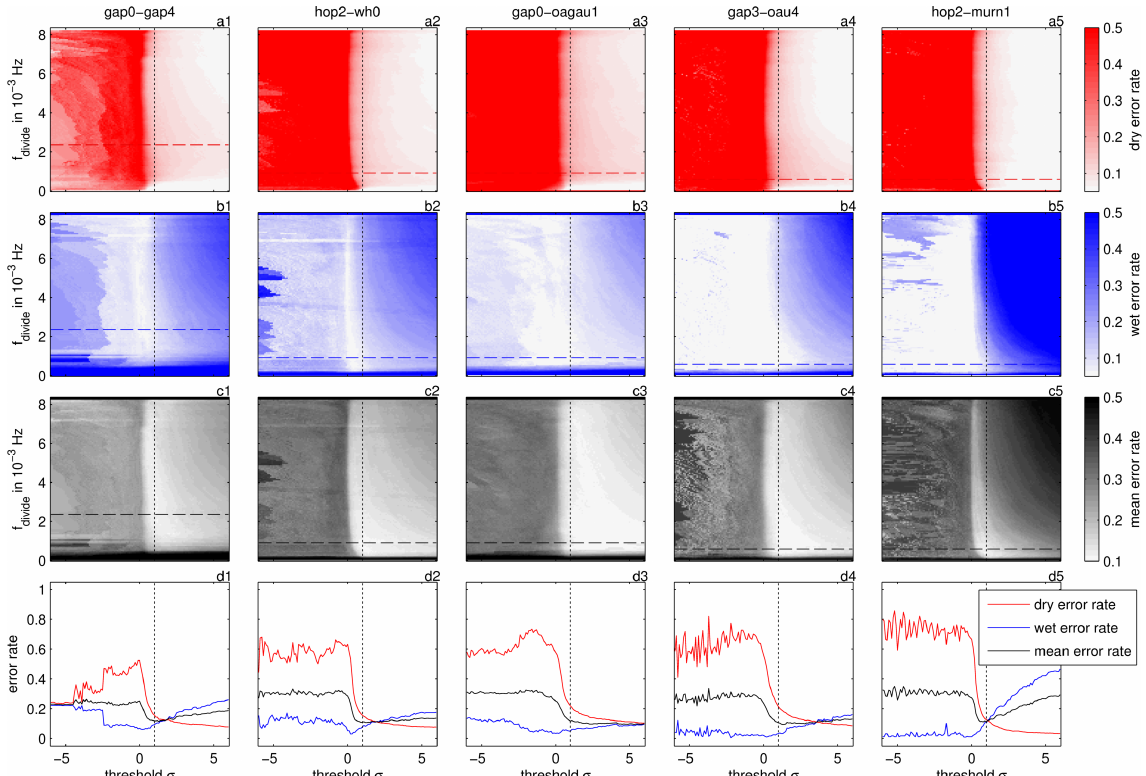
Fig. 5. Wet, dry and weighted mean detection error rates for the five links depending on the threshold σ and the frequency of spectrum division f divide . A window length of 256 was used. The bottommost plots (d1 to d5) show the evolution of the error rates for different σ at a certain f divide indicated by the dashed lines in plots a,b and c. The chosen values for f divide are proportional to the reciprocal of the link length (detail see text). The links are sorted from left to right with increasing